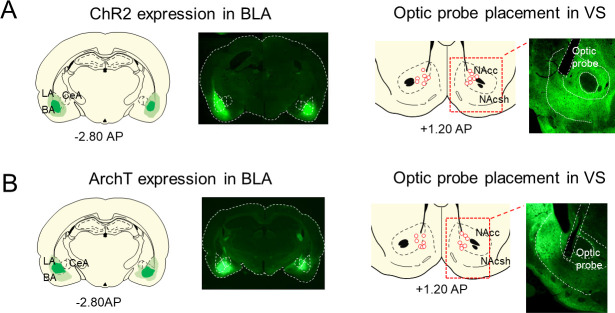
Spread of AAV expression and location of optic probes.(A) Min/max spread of AAV expression with example micrograph. (B) Location of optic fiber tips with example micrograph for each projection tested.